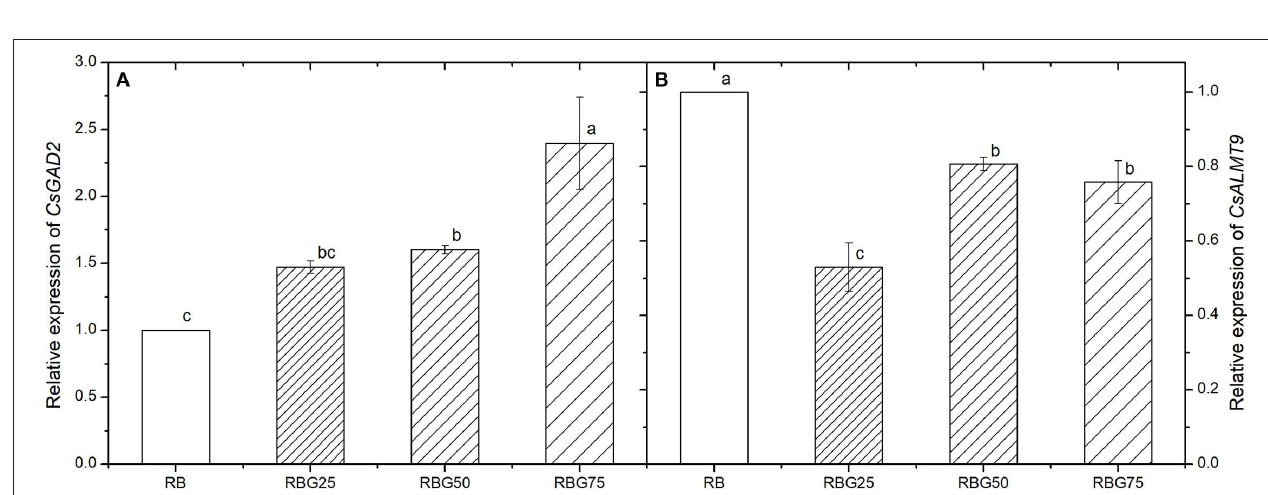
FIGURE 8 | Effect of different spectral conditions on contents of abscisic acid (ABA) and s-aminobutyric acid (GABA) in cucumber seeding leaves after 9 days drought stress. (A) Abscisic acid (ABA) content of cucumber leaves. (B) γ -aminobutyric acid (GABA) content of cucumber leaves. RB, RBG25, RBG50 and RBG75 are the different spectral conditions, respectively. The PPFD for all the treatments was 250 µ mol m − 2 s − 1 . The data presented were the means ± SE ( n = 3). Different lowercase letters on the bar chart indicated significant differences among treatments according to Tukey’s test ( p < 0.05).